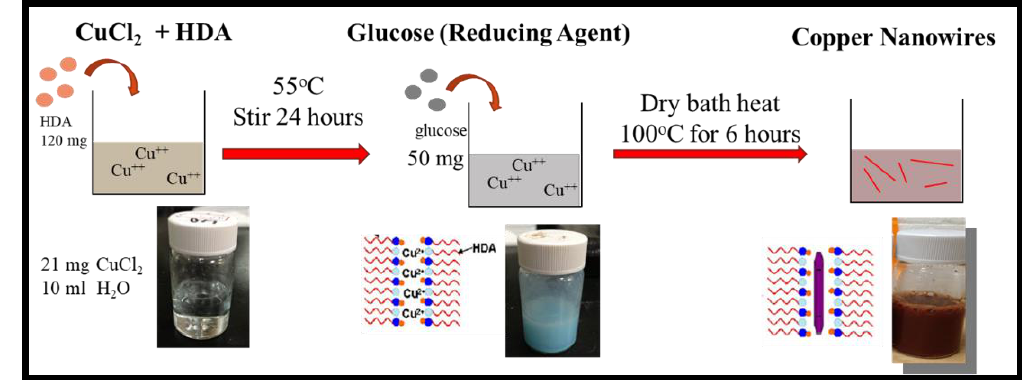
Figure 1. The preparation procedure of copper nanowires (CuNWs).